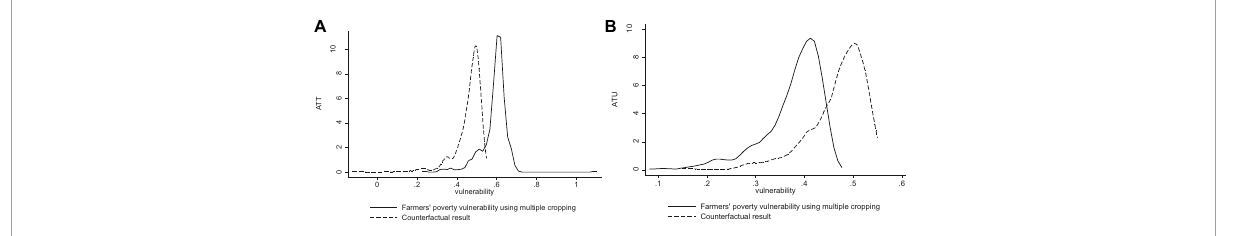
FIGURE1 Relative poverty probability density of farmers with multiple crops (A) and no multiple crops (B) .